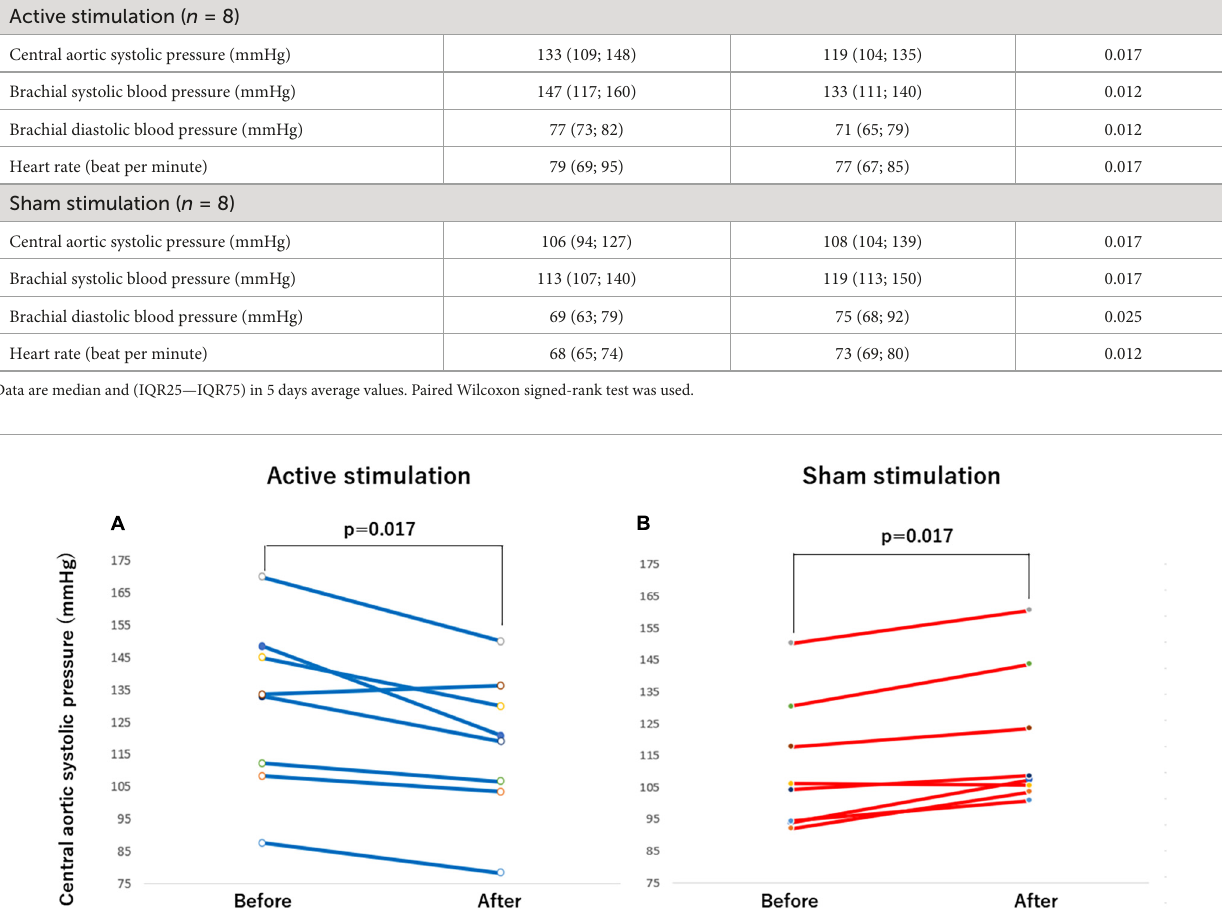
TABLE 2 Central aortic systolic pressure (CASP) before and after stimulation. Variables